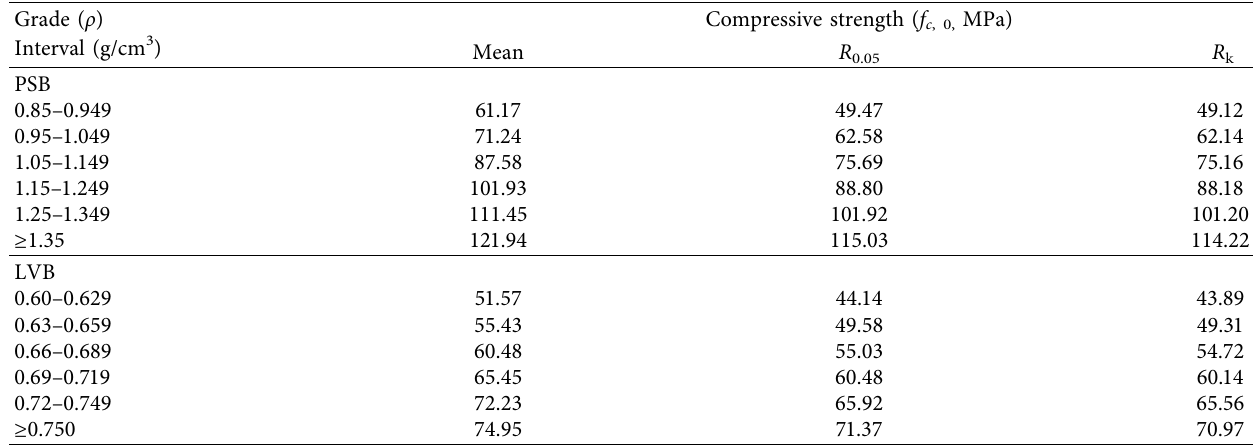
Table 9: Compressive strength grade classification of EBC based on